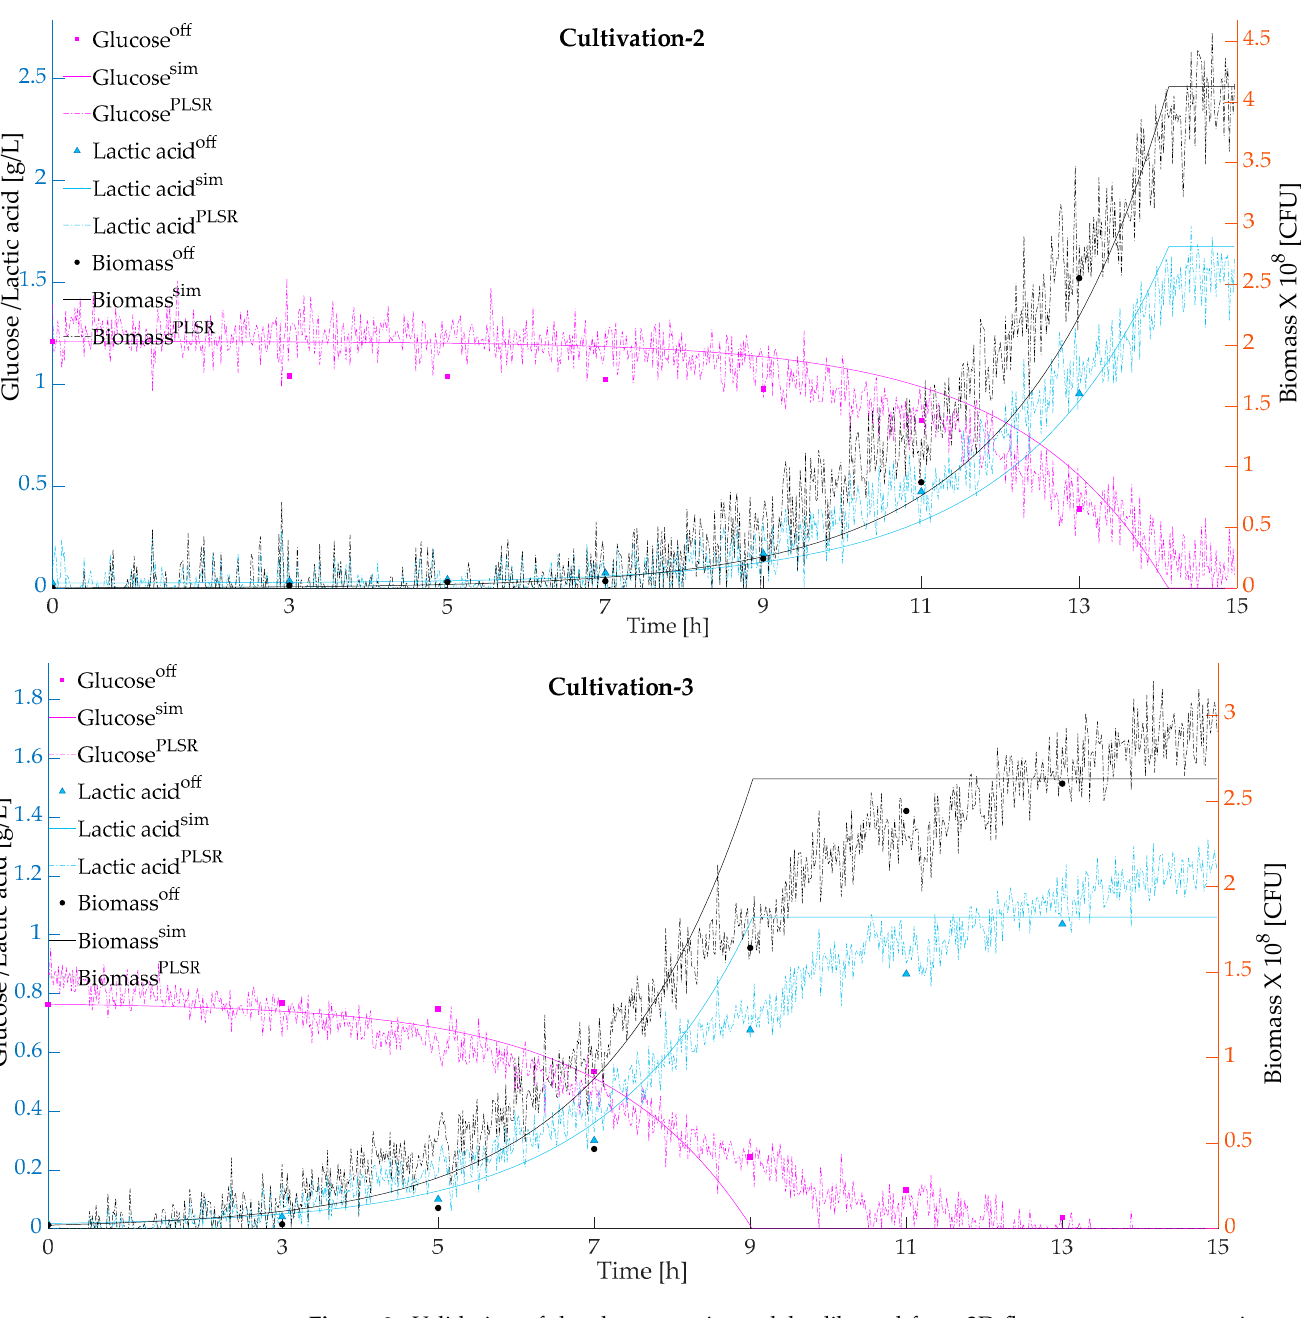
Figure 3. Validation of the chemometric model calibrated from 2D fluorescence spectra using a model-based calibration approach to predict biomass, glucose, and lactic acid, aligned with the actual o ffl ine measurements.